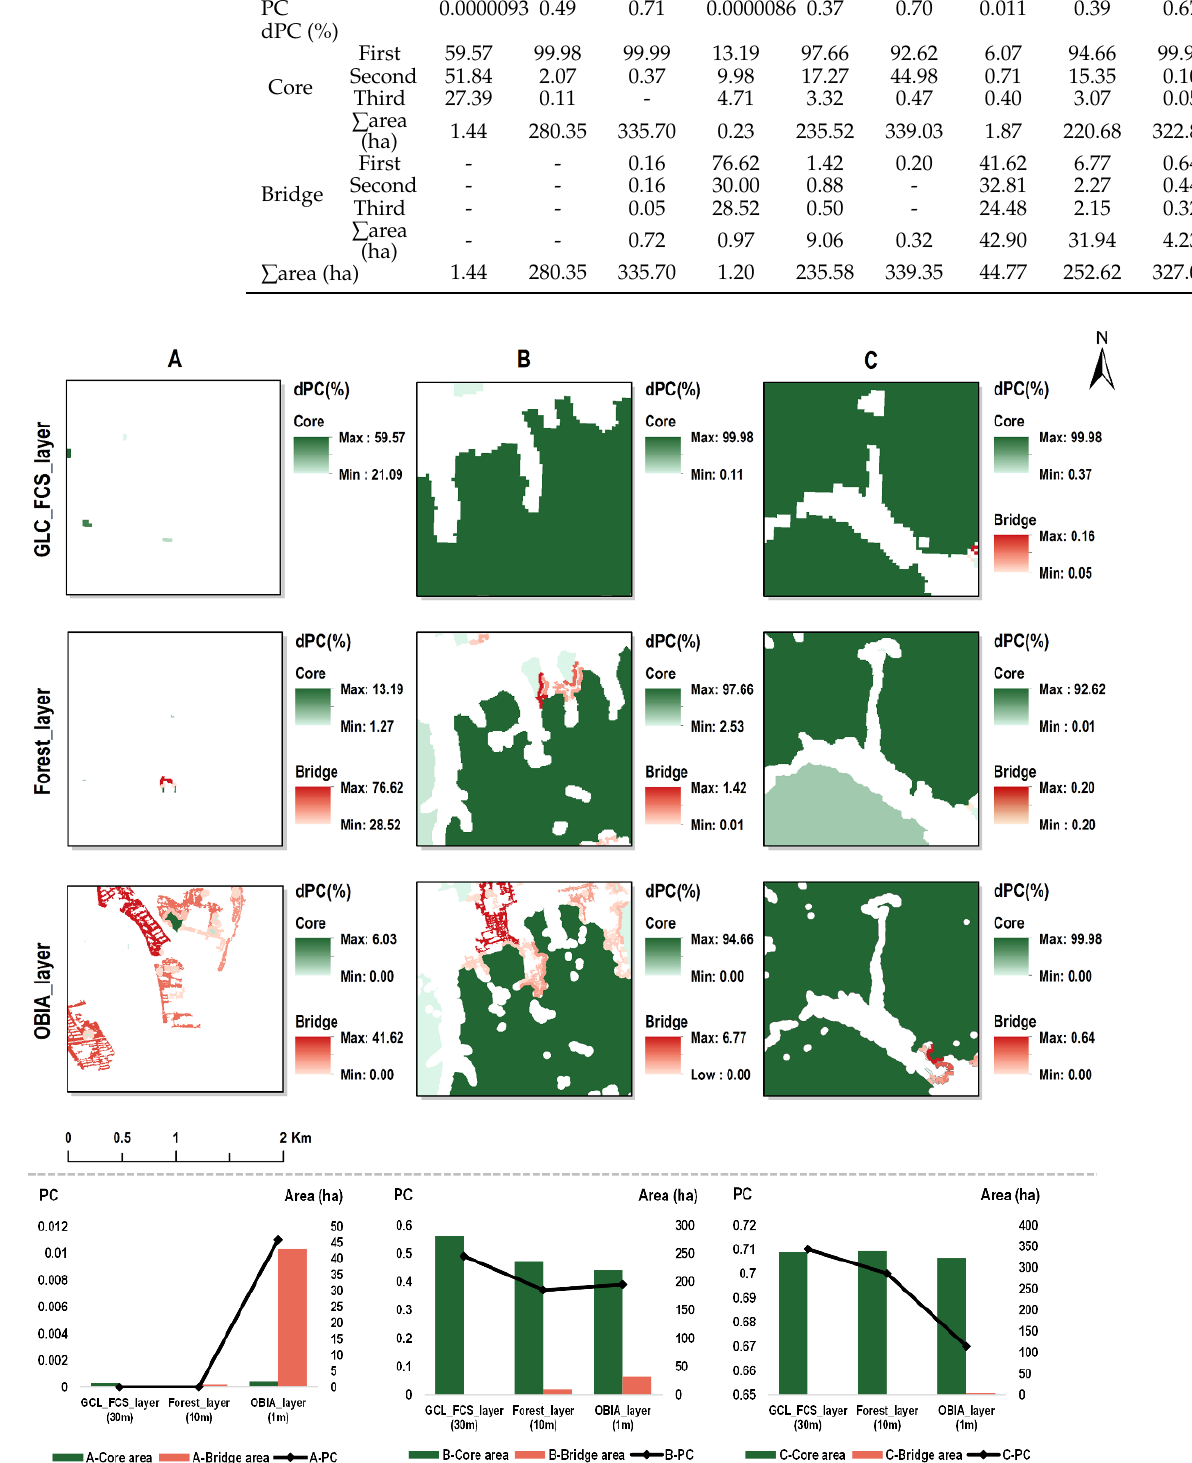
Figure 6. Distribution of the top important three Cores and Bridges in the urban gradient scenarios of the three maps. The distributions of urban gradient scenario A, B, and C are in Figure 1. The bottom charts show the PC value and Core/Bridge area of different maps in the corresponding study area.